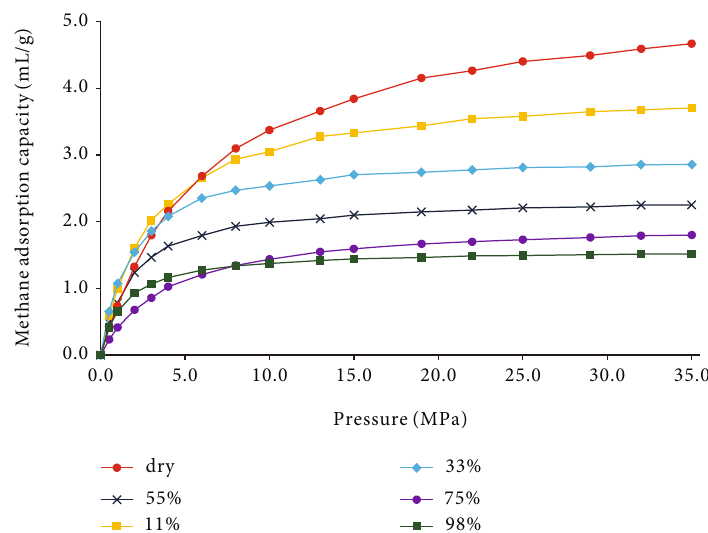
Figure 4: Methane adsorption isotherms of shale under di ff erent humidity conditions. As the humidity increases, the methane adsorption capacity of the sample decreases.